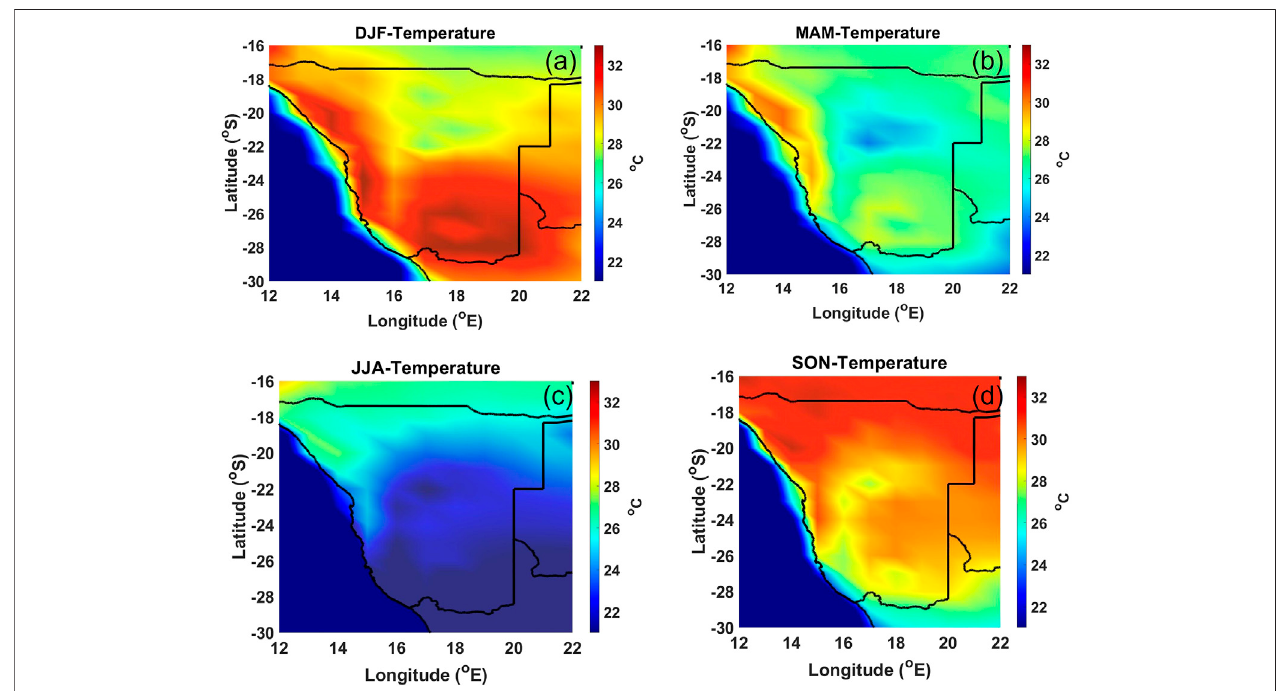
FIGURE 6 | Seasonal averaged temperature for the period of 1998 – 2020 in (A) DJF, (B) MAM, (C) JJA and (D) SON, obtained from AIRS.